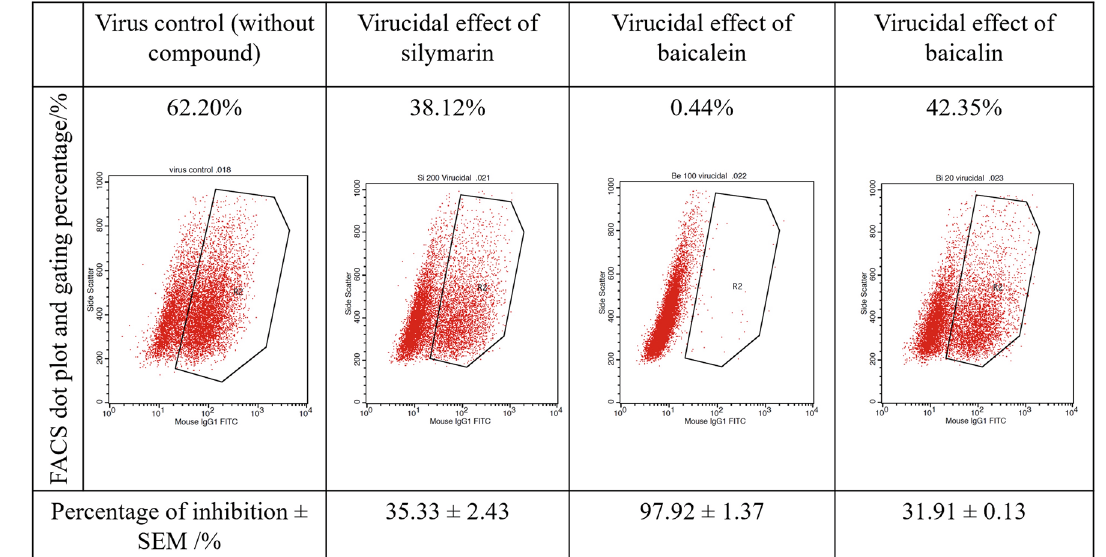
Figure 6. FACS-based assay to measure flavonoids’ virucidal activity against DENV-3. For each sample, 10,000 events were collected and analyzed. Among the 10,000 events, the FITC-positive population for each sample was shown. The percentage of inhibition was calculated as the percentage of infected cells with flavonoid treatment compared to the percentage of infected cells without flavonoid treatment. Results were represented as the mean ± standard error of the mean (SEM) from triplicate assays determined from three independent experiments.